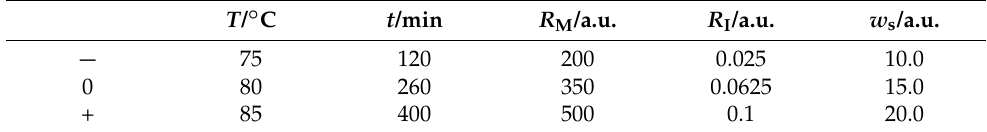
Table 1. Low ( − ), center (0) and high (+) level for each factor examined in the FC-CCD. T / ◦ C t /min R M /a.u. R I /a.u. w s